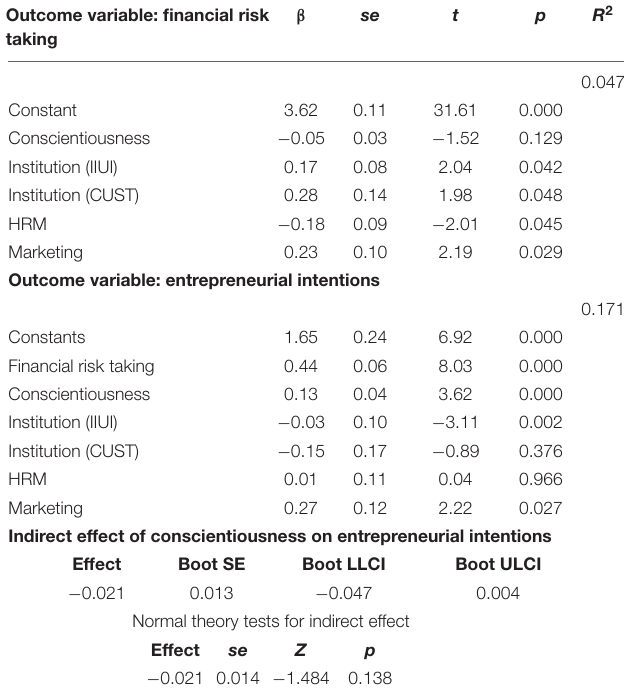
TABLE 6 | Mediating role of financial risk taking between conscientiousness and entrepreneurial intentions. Outcome variable: financial risk taking